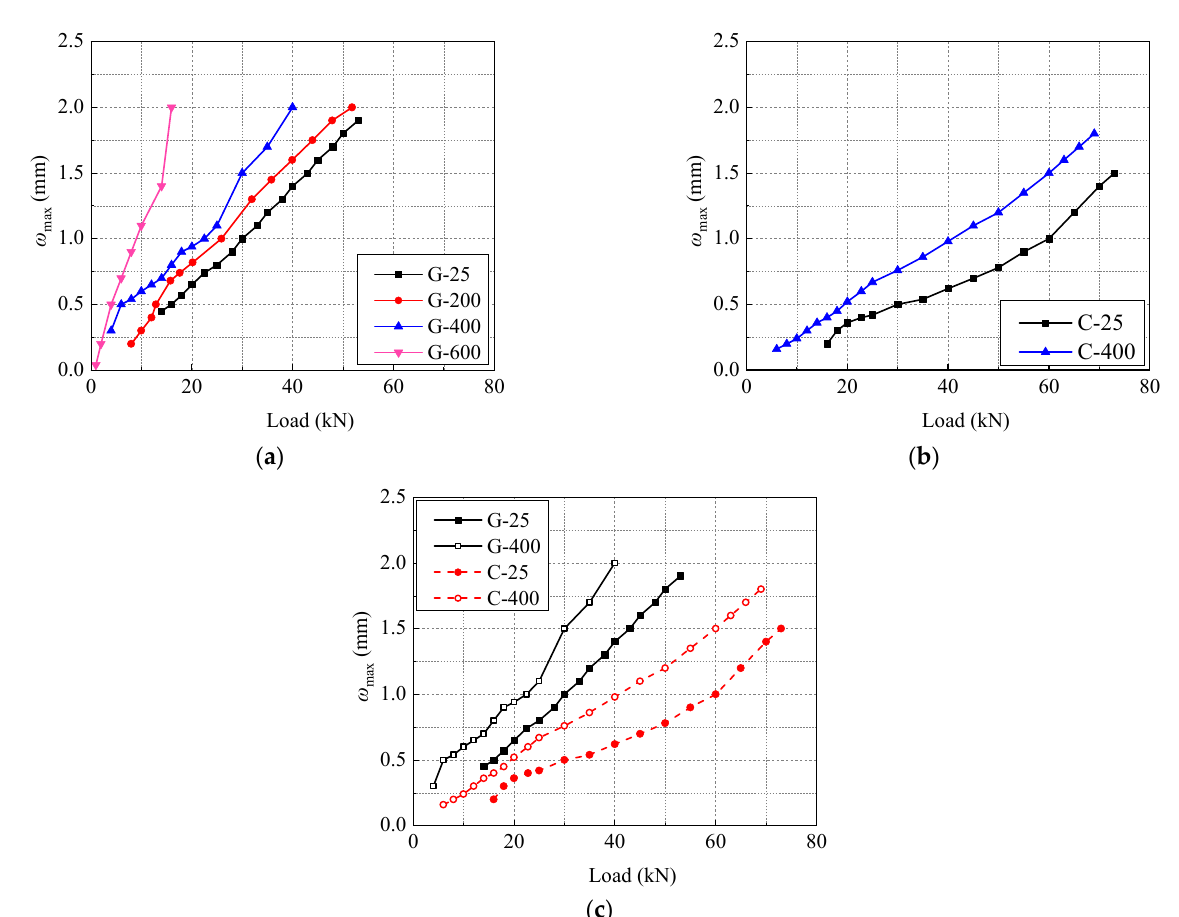
Figure 8. Developments of maximum crack width ( ω max ) of beams with different FRP bar types after elevated temperature exposure: ( a ) effect of temperature of GFRP bar; ( b ) effect of temperature of CFRP bar; ( c ) effect of FRP bar type.